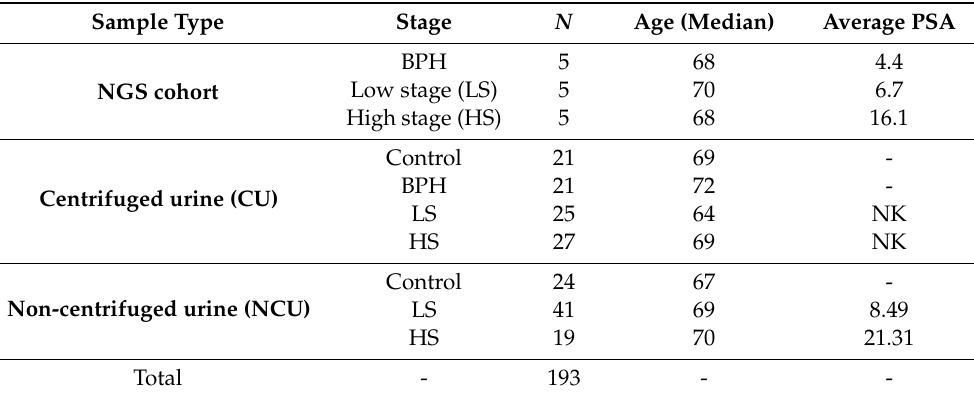
Table 1. Summary of di ff erent cohorts used for this